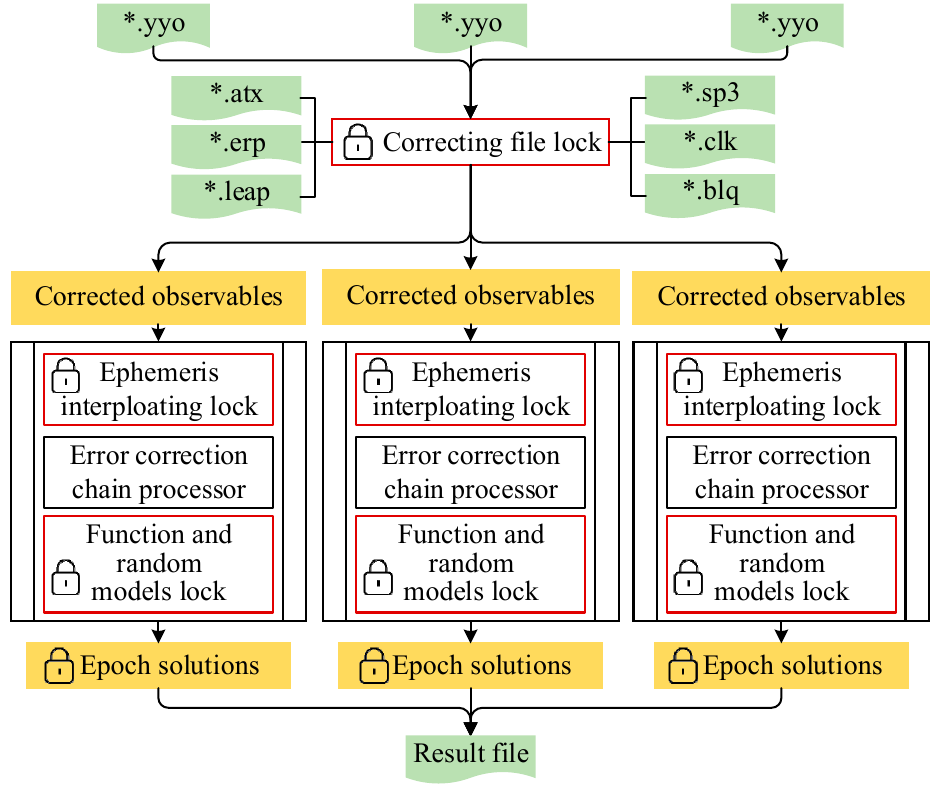
Figure 1. The fi ner-grained parallel computing fl owchart of undi ff erenced and uncombined PPP Figure 1. The finer-grained parallel computing flowchart of undifferenced and uncombined PPP under a multicore platform. The symbol * represents the station name. under a multicore platform. The symbol * represents the station